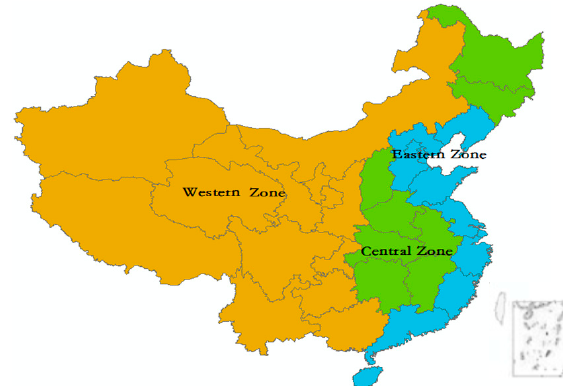
Figure 5. Division of the three economic zones.